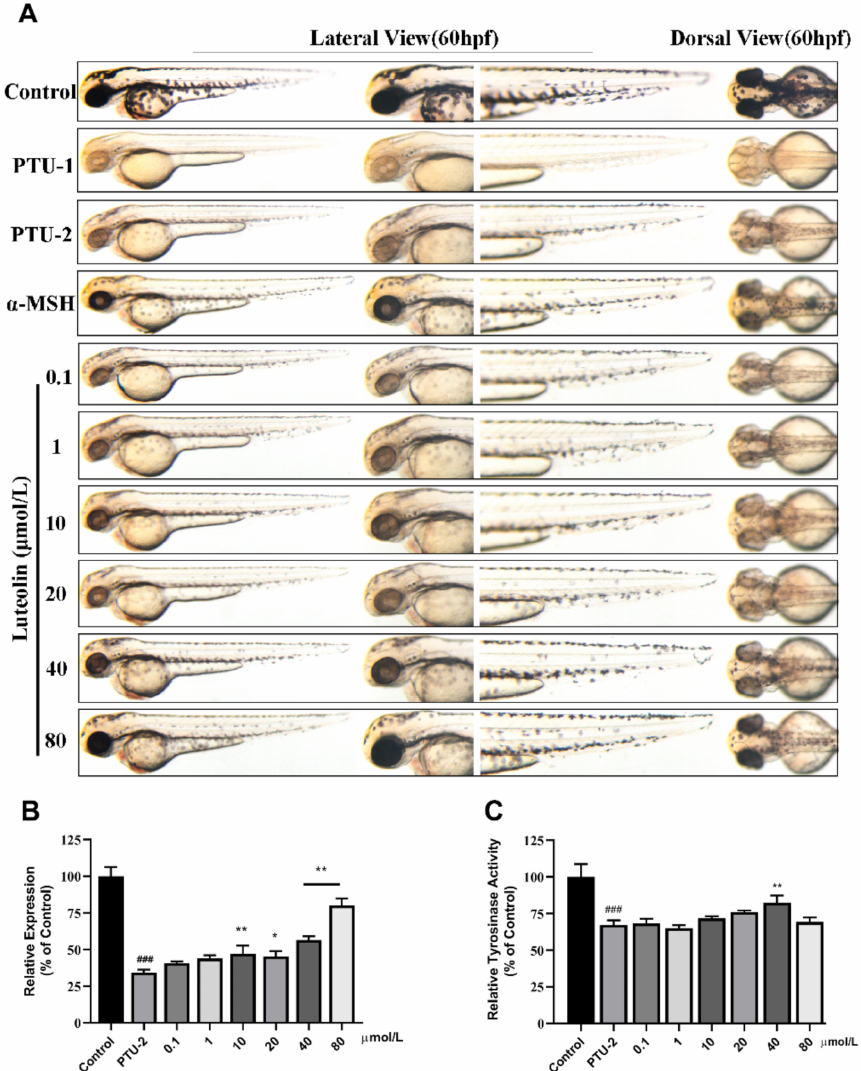
Figure 6. Effect of luteolin on melanogenesis in vivo. ( A ) Zebrafish melanin phenotype in various concentrations of luteolin [0.1, 1, 10, 40 and 80] µ mol · L − 1 , the α -MSH is 60 µ mol · L − 1 , and the PTU-1 group was not washed at all while the PTU-2 group was washed before administration. ( B ) Collecting zebrafish in each group for testing melanin content (relative expression % of control). ( C ) Tyrosinase activity in zebrafish exposure to butin for 24 h. In B and C, results shown are mean ± SEM. Data were analyzed by ANOVA followed by post hoc Tukey test. n = 30 zebrafish, ### p < 0.001 vs. Control, ** p < 0.01, * p < 0.05 vs.